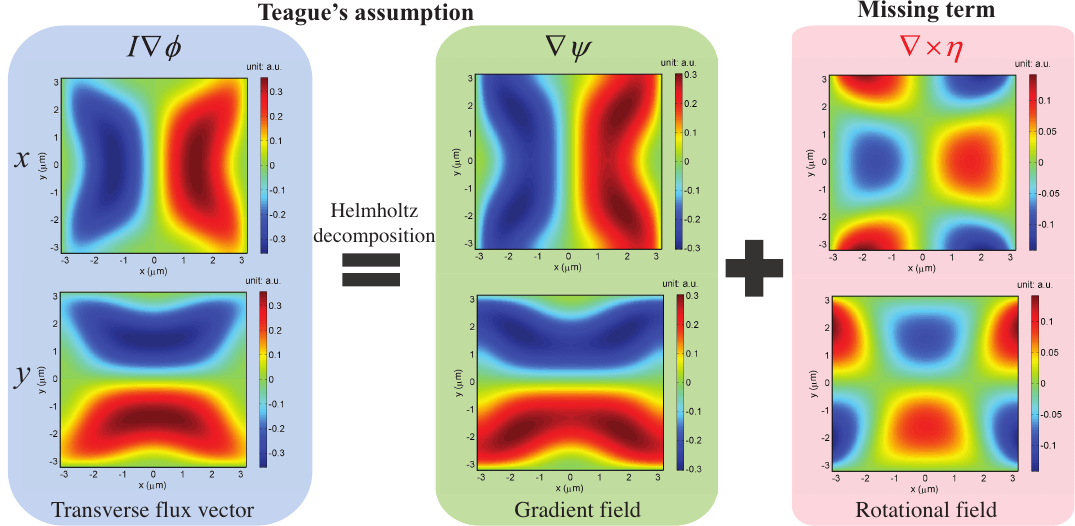
Figure 16. Helmholtz decomposition of the transverse flux field. The x and y components of the vector fields are shown in the first row and the second row, respectively. The term ∇ × η is missing in Teague’s